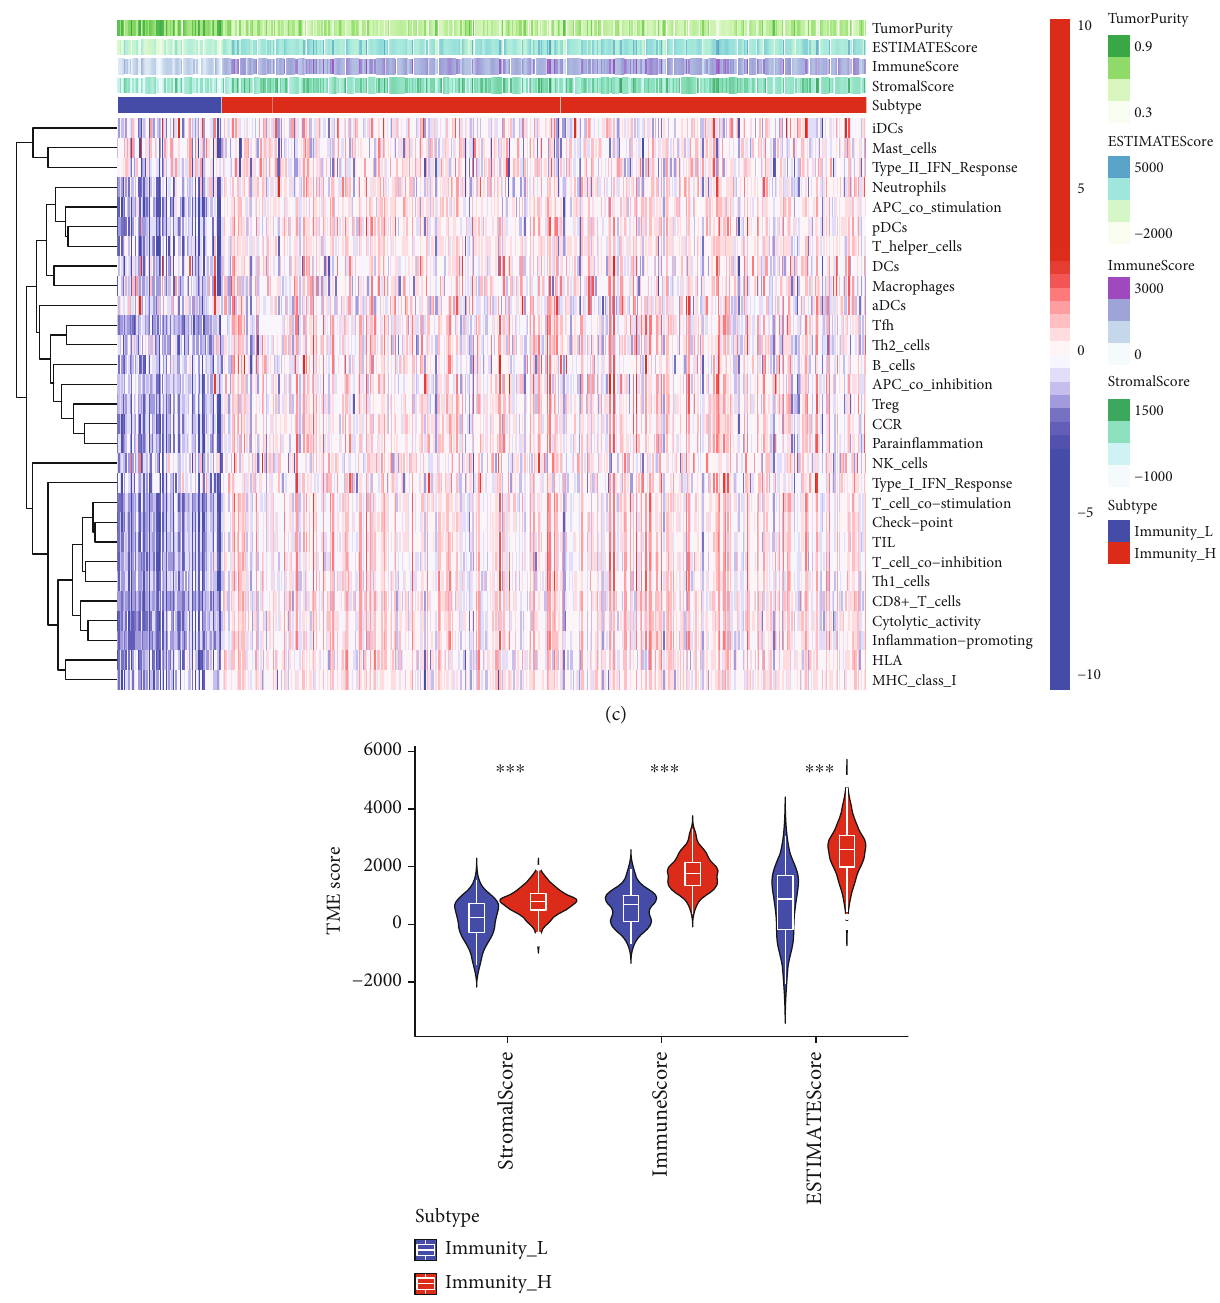
Figure 1: Immune strati fi cation and clustering in patients with KIRC. (a) According to ssGSEA analysis, KIRC was divided into Immunity_H and Immunity_L based on immune score and hierarchical clustering algorithm. (b) The cluster analysis of KIRC patients was further con fi rmed by tSNE. (c) The immune characteristics of TCGA-KIRC cohort and the landscape of tumor microenvironment. (d) ImmuneScore, StromalScore, and ESTIMATEScore were compared in Immunity_H and Immunity_L. ∗ p < 0 : 05 , ∗∗ p < 0 : 01 , and ∗∗∗ p < 0 : 001